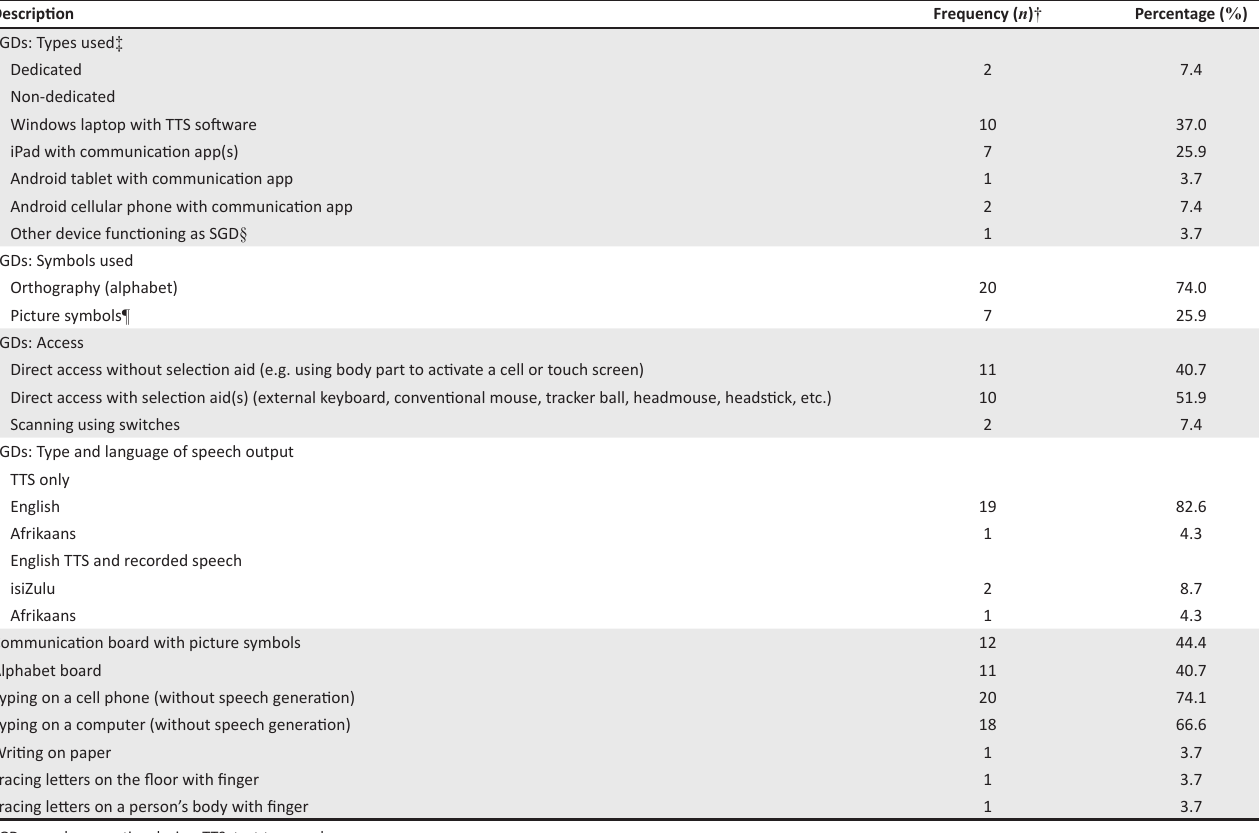
TABLE 2: Orthography- and picture-based augmentative and alternative communication systems and strategies used by the participants.